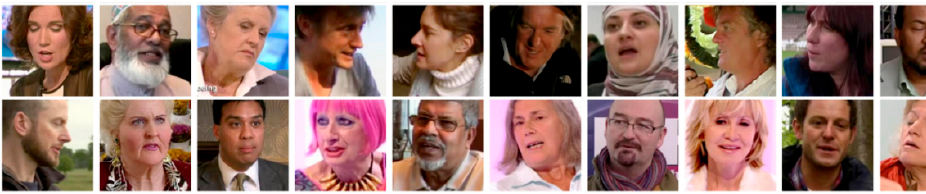
Figure 3. Example data from the LRS2 dataset [25].